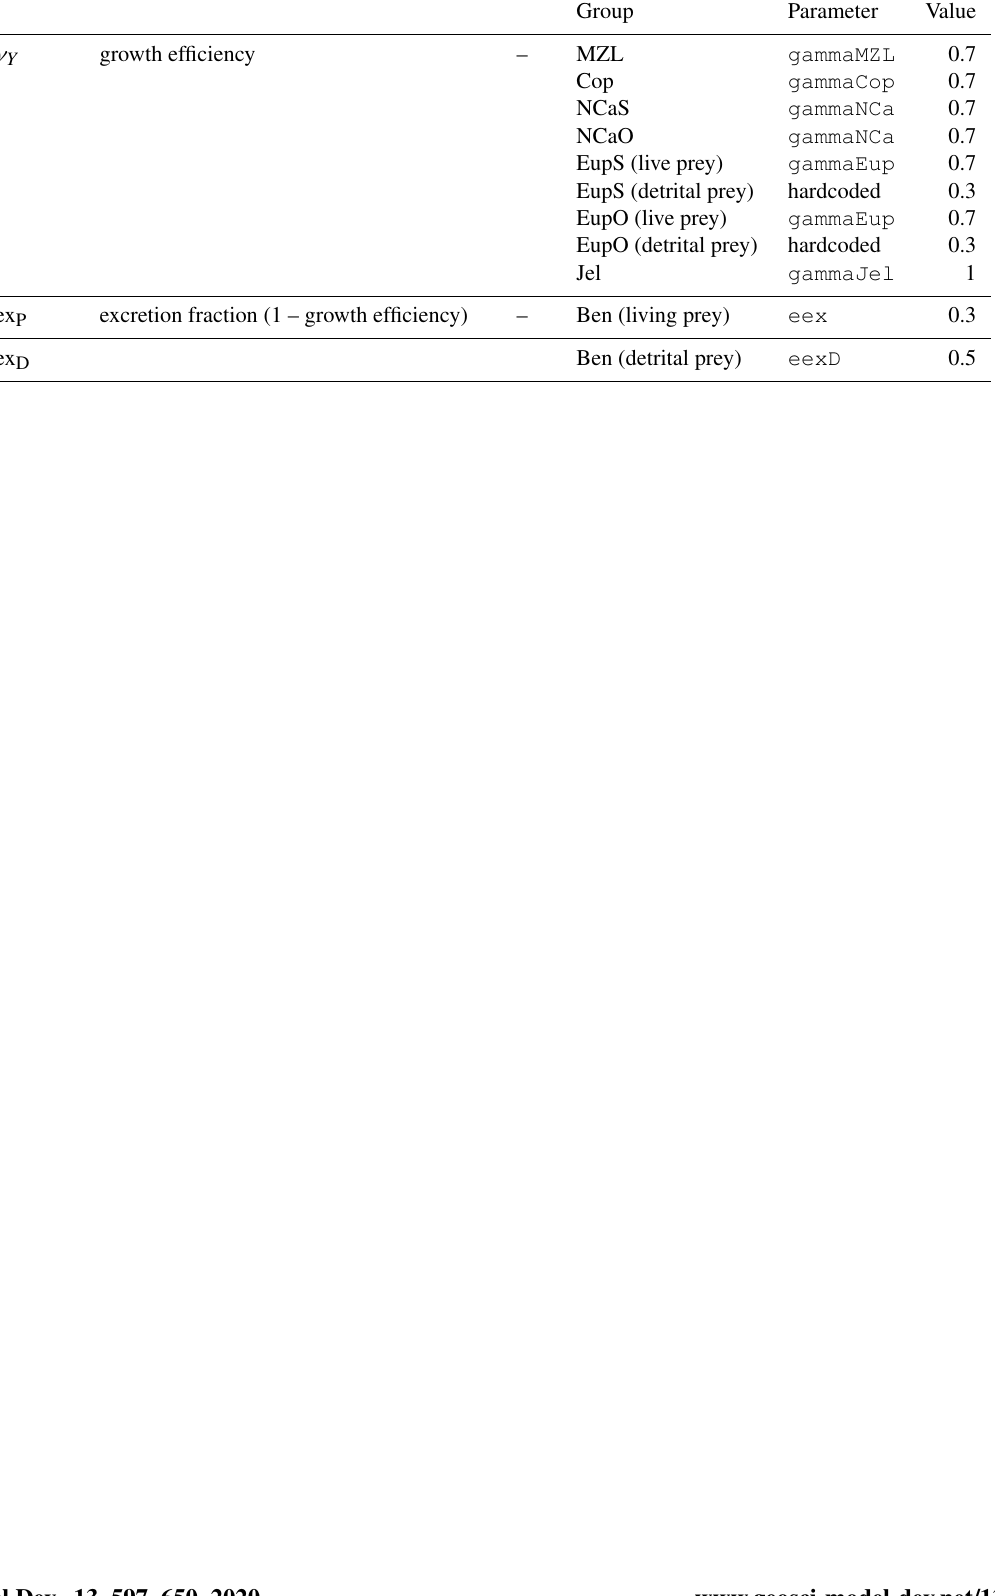
Table A8. Notation and description for input parameters related to egestion and excretion.